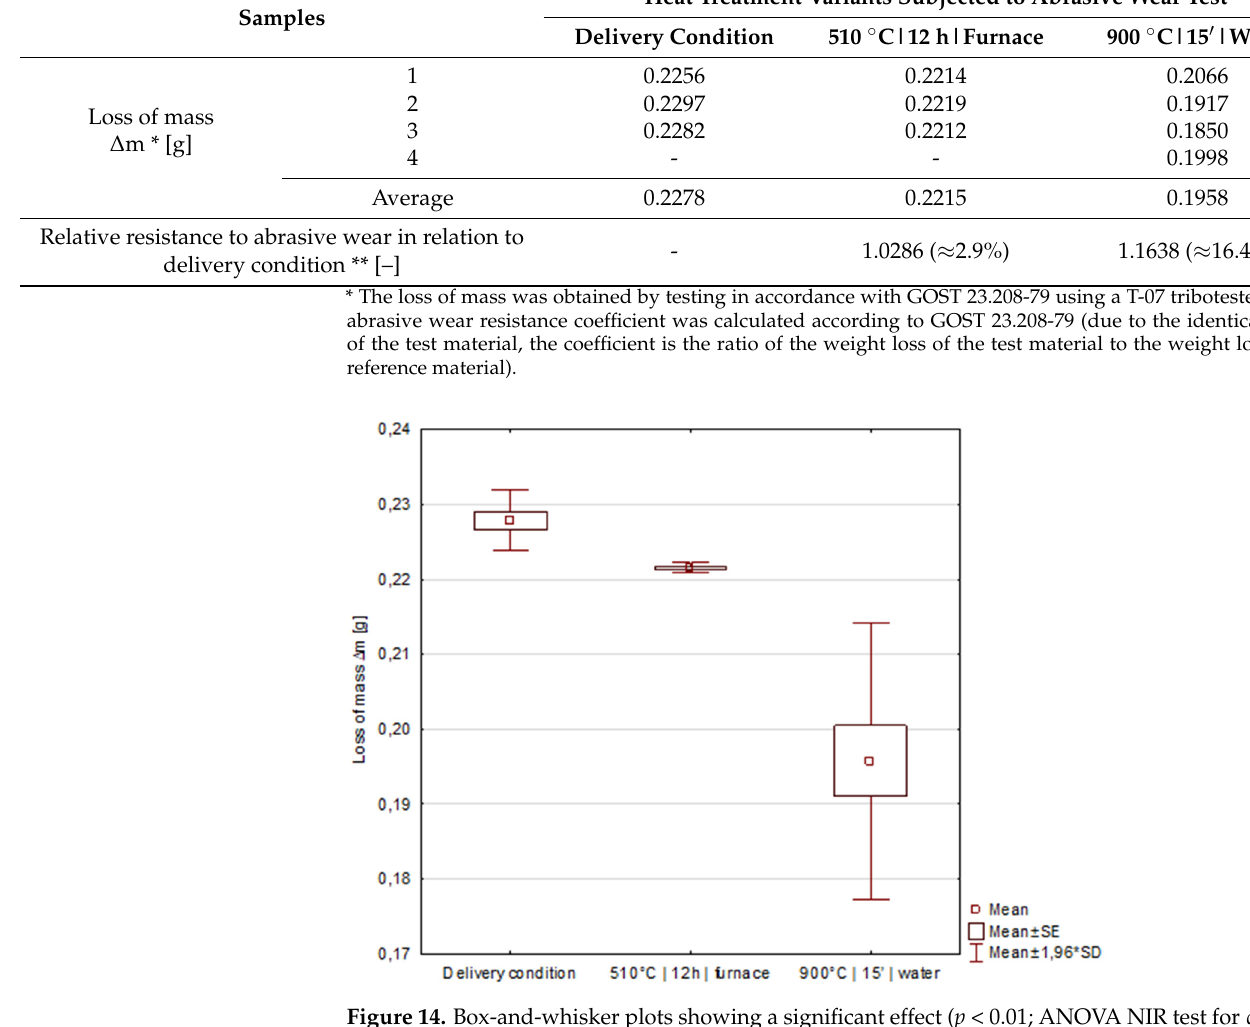
Figure 14. Box-and-whisker plots showing a significant effect ( p < 0.01; ANOVA NIR test for α = 0.05) on the increase in abrasive wear resistance of X120Mn12 steel relative to the delivery condition achieved by the modified heat treatment process.